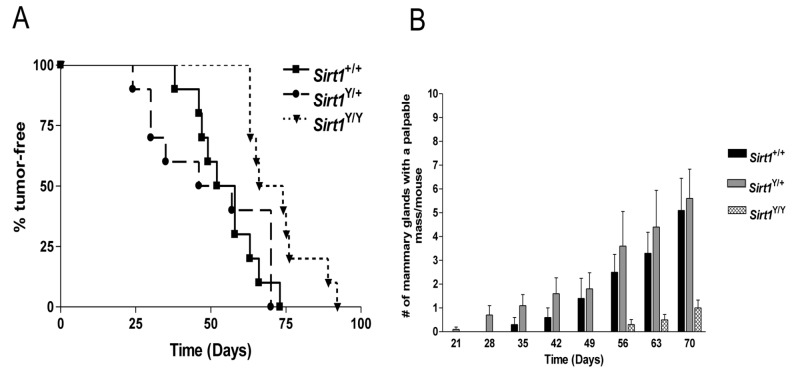
Loss of SIRT1 catalytic activity is associated with increase tumor latency
A) Kaplan Meir plot measuring the percentage of mice without any palpable mammary gland mass at the given age. N= 10 mice per genotype. There was a significant delay in the time at which the Sirt1
Y/Y developed their first detectable mass as compared to the Sirt1
+/+ and the Sirt1
Y/+ mice (P <0.01 and P < 0.05, respectively). B) The mean number of mammary glands with a palpable mass over time as measured at weekly intervals after birth. N= 10 mice per genotype. Error bars indicate SEM.